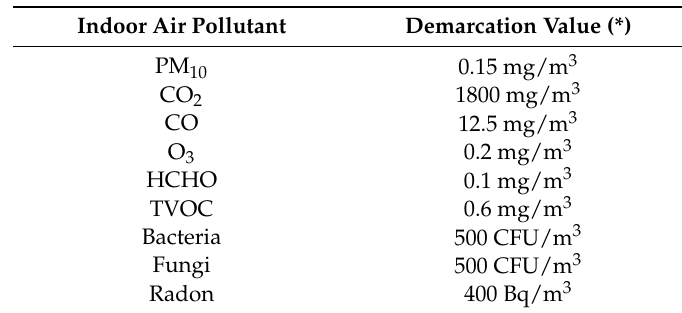
Table 1. Indoor air pollutant limit values per Portuguese